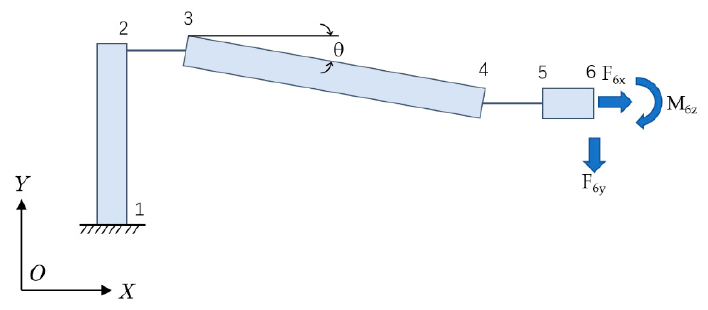
Figure 4. Bounding conditions and loading for quarter-model.